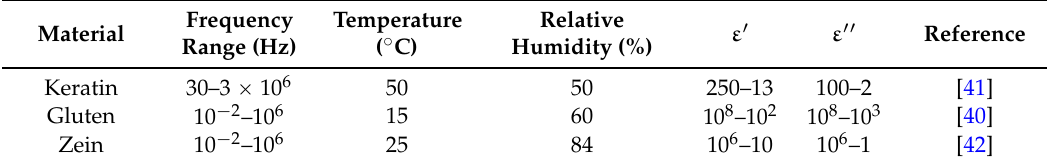
Table 3. Dielectric permittivity and loss values of protein films at low relative humidity (<50% RH). Material